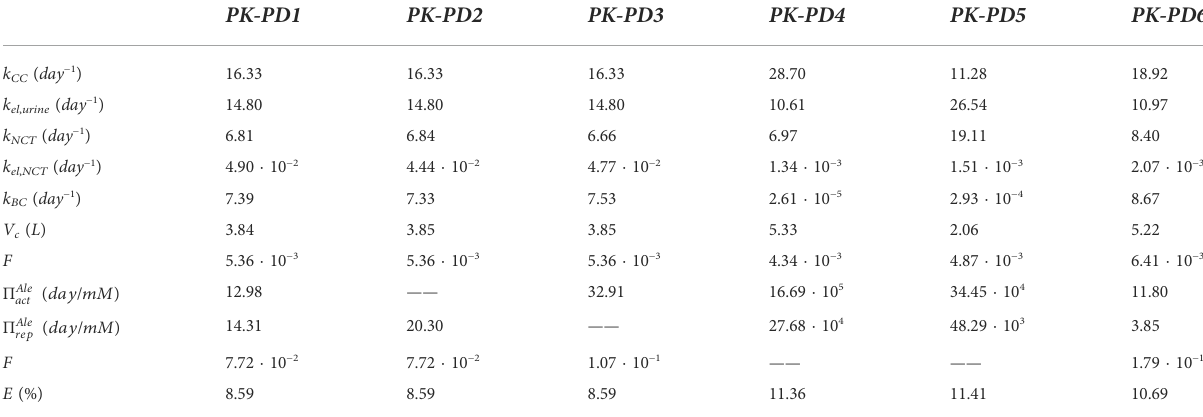
TABLE 2 Summary of parameter values for alendronate PK models. Fitted for the complete model ( PK-PD1 ), for the model that does not take into account the in fl uence of alendronate on the apoptosis of osteoclasts ( PK-PD2 ), for the model that does not consider its in fl uence on the resorbing capacity of osteoclasts ( PK-PD3 ), for the model in which the active subcompartment does not exhibit saturation ( PK-PD4 ), for the model that ignores the distinction between the active and inactive subcompartments ( PK-PD5 ), and for the model that ignores that distinction but implements saturation in the BC ( PK-PD6 ). E is the error as de fi ned in Eq. 30.